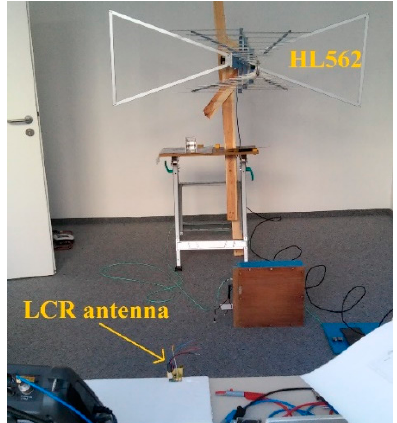
Figure 21. Measurement setup for the proposed miniature LCR antenna for wall and ground-probing applications.